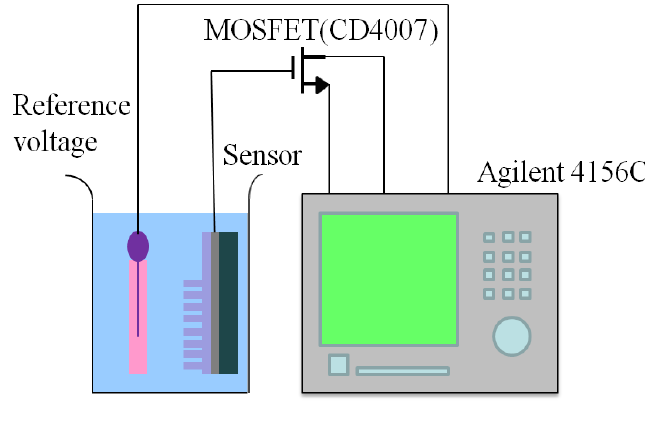
Figure 2. The measurement system of ZnO nanorod glucose biosensors.